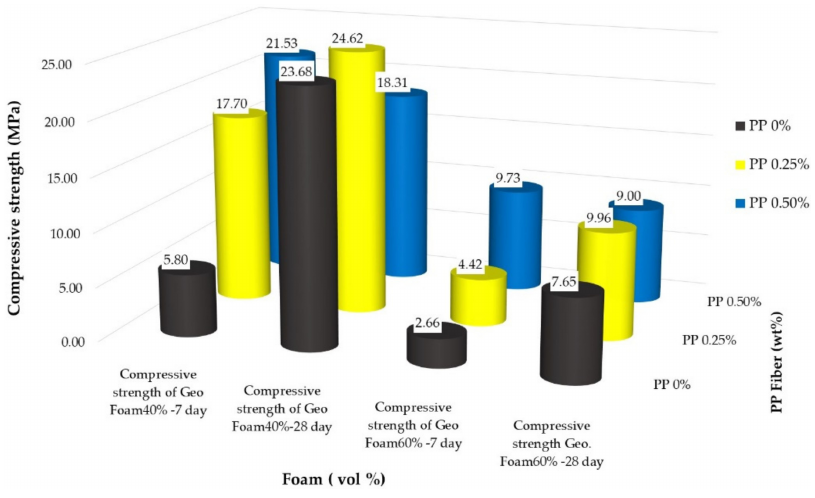
Figure 6. The effect of PP fiber on the compressive strength of foamed